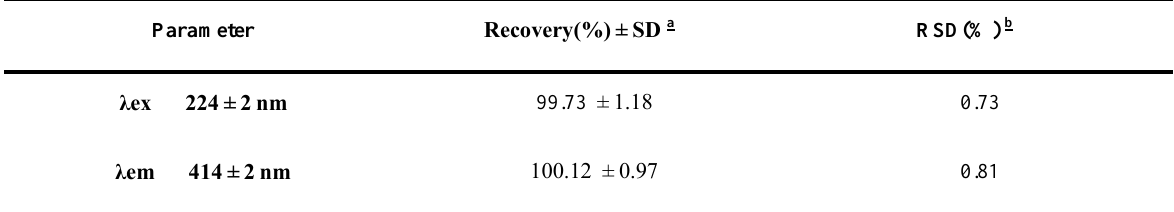
Table 4: Robustness of the proposed spectrofluorimetric method